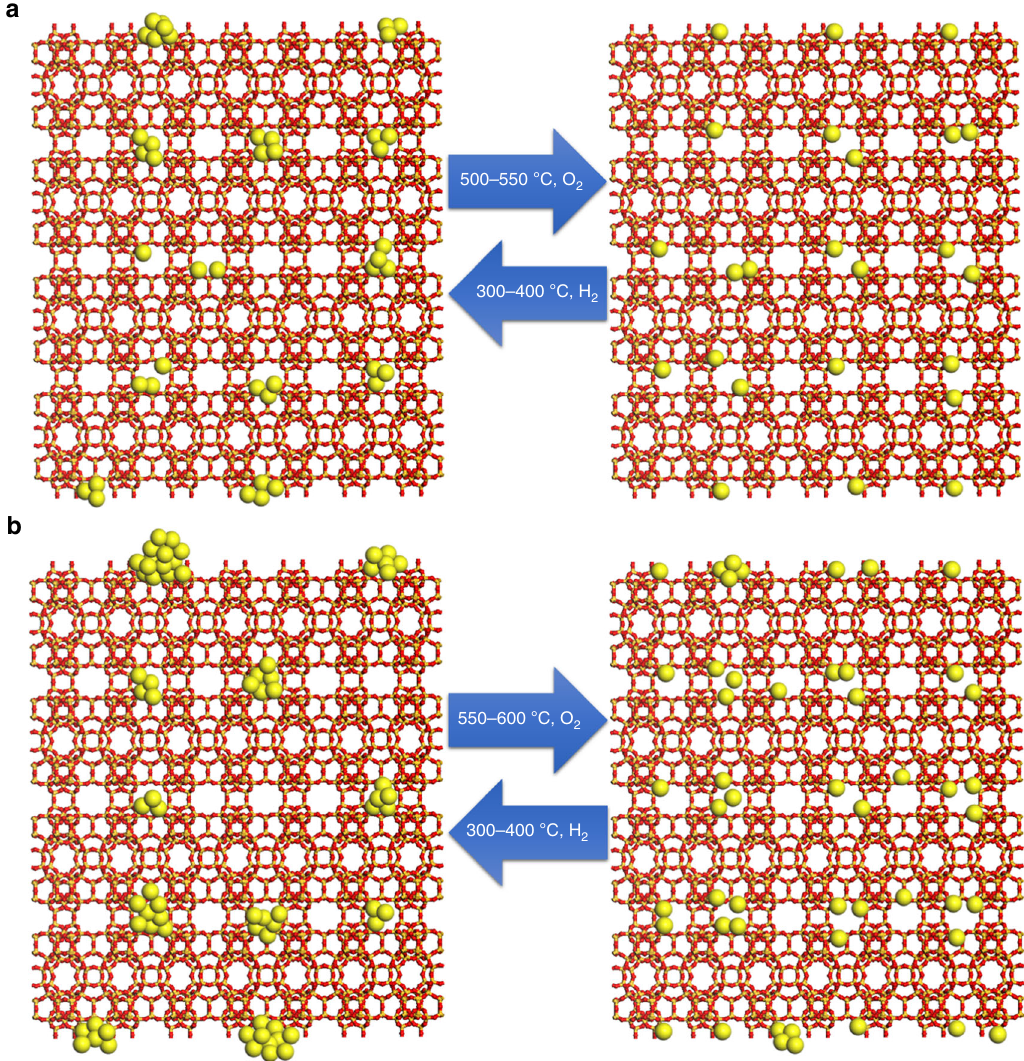
Fig. 2 Structural evolution of Pt@MCM-22 under redox conditions. a In the case of Pt@MCM-22 material with low Pt loading ( ≤ 0.1 wt%), Pt mainly exist in internal space of MCM-22 crystallites, as shown in our previous work 11 . Therefore, the redispersion of Pt can be achieved under relatively mild conditions. Subnanometric Pt clusters and small Pt nanoparticles (1 – 2 nm) are formed in subsequent reduction treatment by H 2 . b In the case of Pt@MCM- 22 material with higher loading ( > 0.15 wt%), some of the Pt species will form Pt nanoparticles and locate on the external surface of MCM-22, which need treatments at higher temperature as driving force to achieve the redispersion. Subsequent reduction treatment by H 2 will cause the agglomeration of Pt species on the surface, giving Pt nanoparticles ( > 2